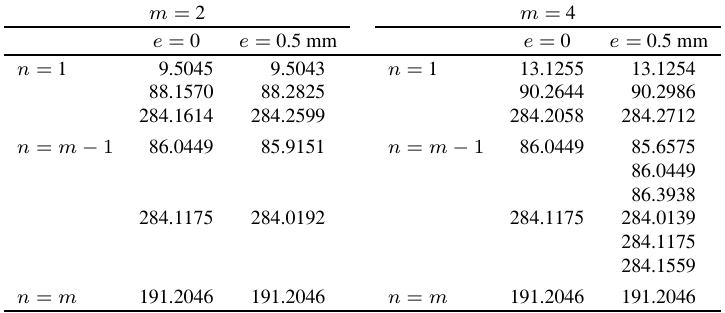
Table 4 Natural frequencies of the drive system with eccentric center stator